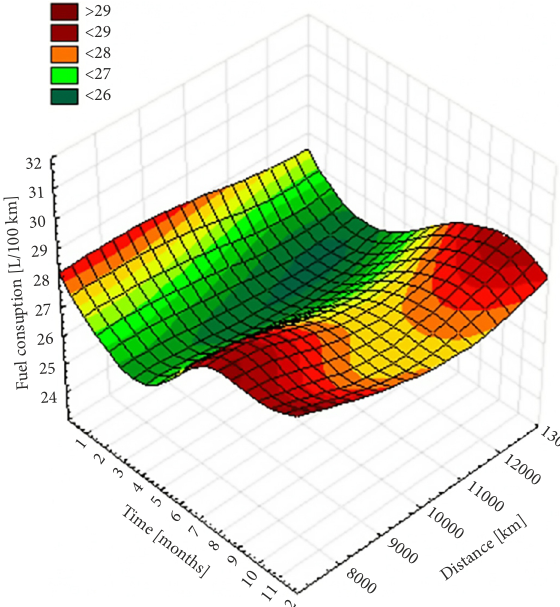
Figure 5. FCs a function of distance and the time (3D space)